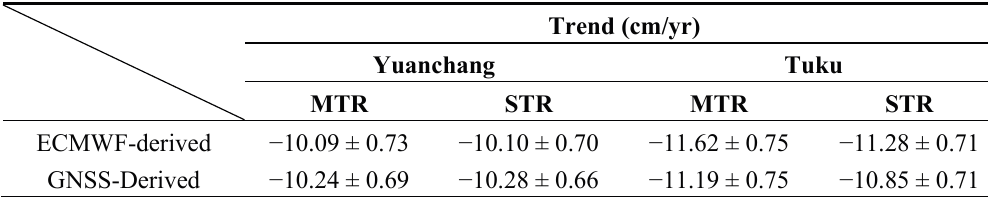
Figure 9. Retracked altimetric LSA corrected by GNSS-derived and ECMWF wet troposphere delays in Tuku, ( a ) retracking by MTR; ( b ) retracking by STR. Blue and red curves represent the corrections of GNSS- and ECMWF-derived delays, respectively. Table 1. Trends of LSAs corrected by GNSS- and ECMWF-derived wet troposphere delays in Yuanchang and